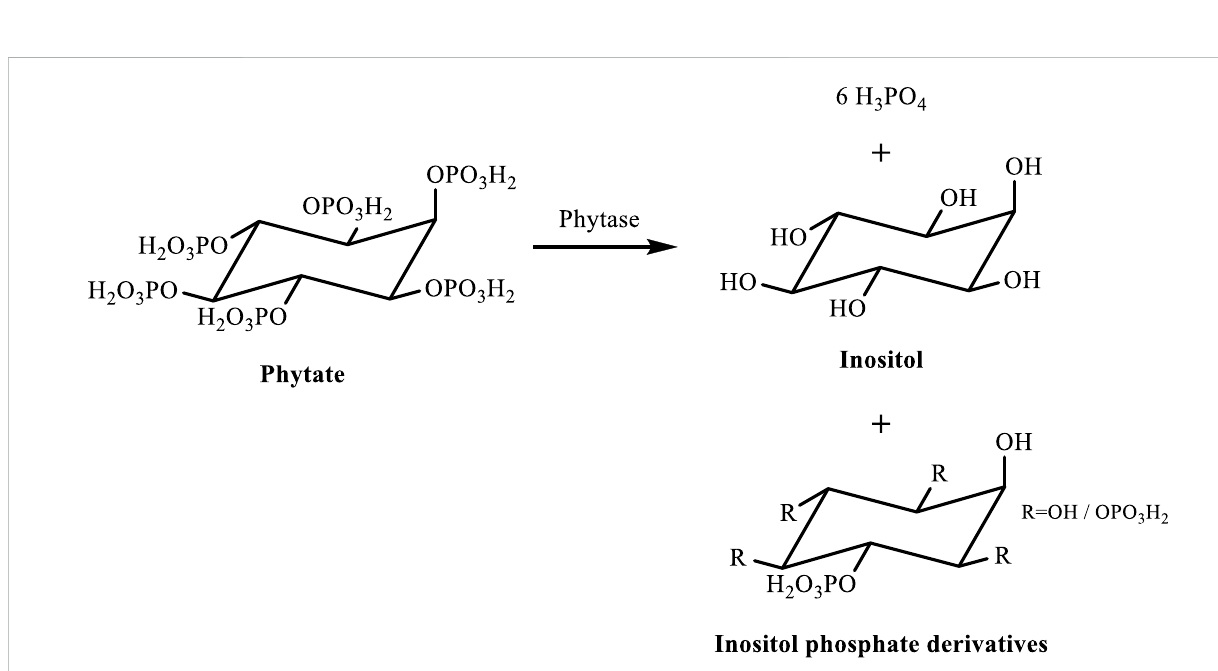
FIGURE 2 Phytate hydrolysis in inositol, inositol phosphate derivatives, and orthophosphate (Lei and Porres, 2003).